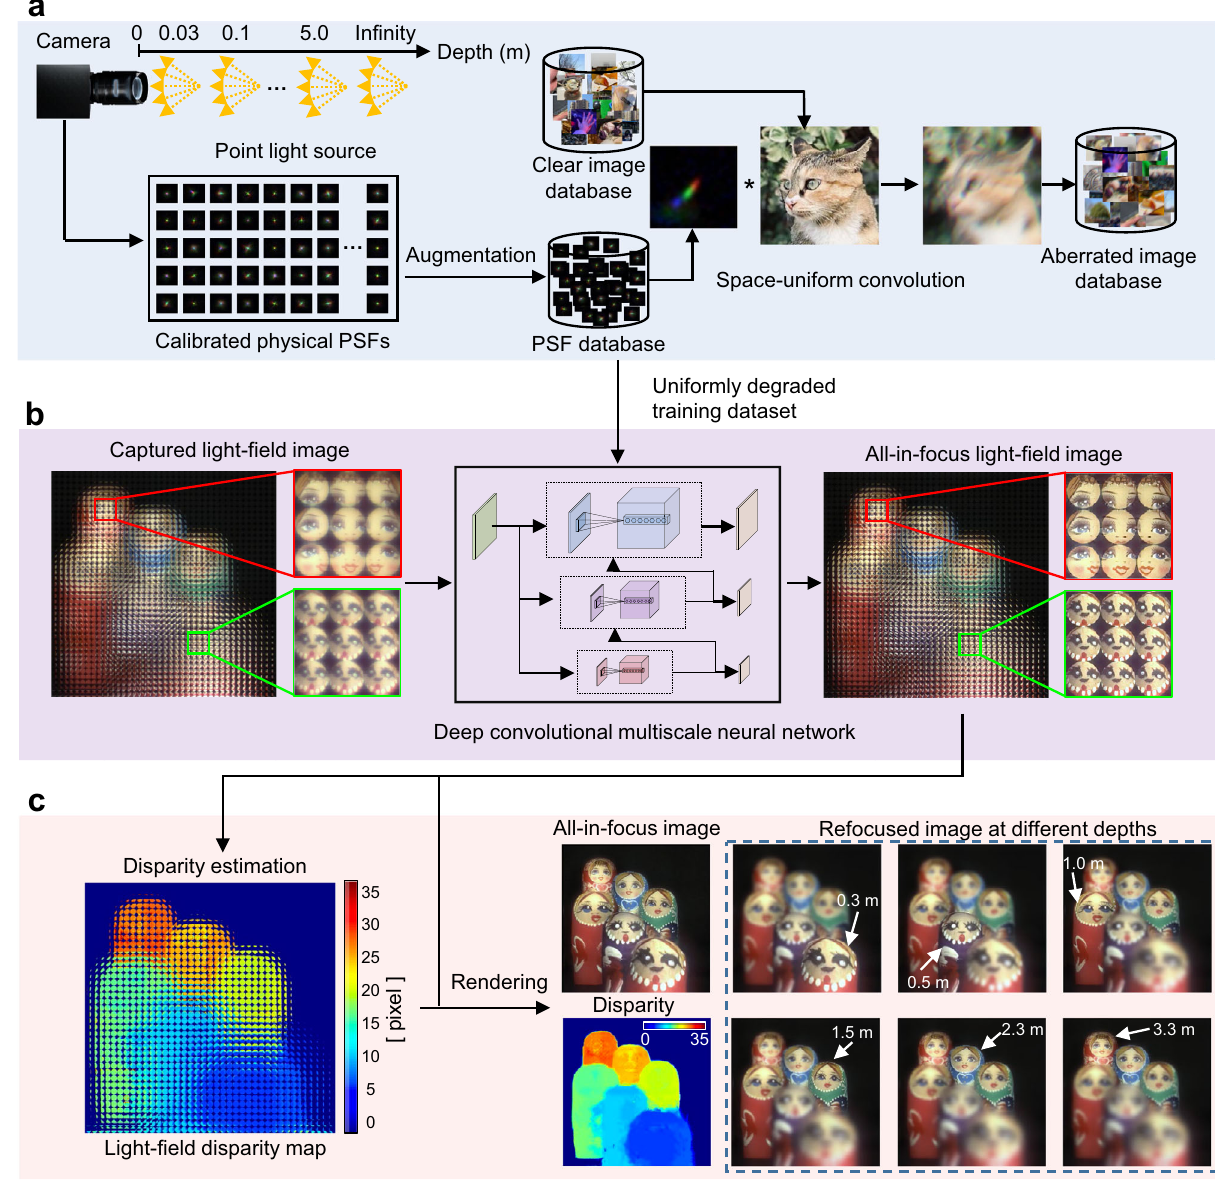
Fig. 4 The neural network-based reconstruction algorithm processing fl ow. a PSF capture and training-data generation. b Aberration removal with the proposed multiscale deep convolutional neural network. The distance between the primary lens and Matryoshka nesting dolls: 0.3 m, 0.5 m, 1.0 m, 1.5 m, 2.3 m, and 3.3 m. The insets show the nearest and farthest Matryoshka nesting dolls. c Light- fi eld processing based on the retrieved all-in-focus light- fi eld images, including disparity estimation and refocusing images at different